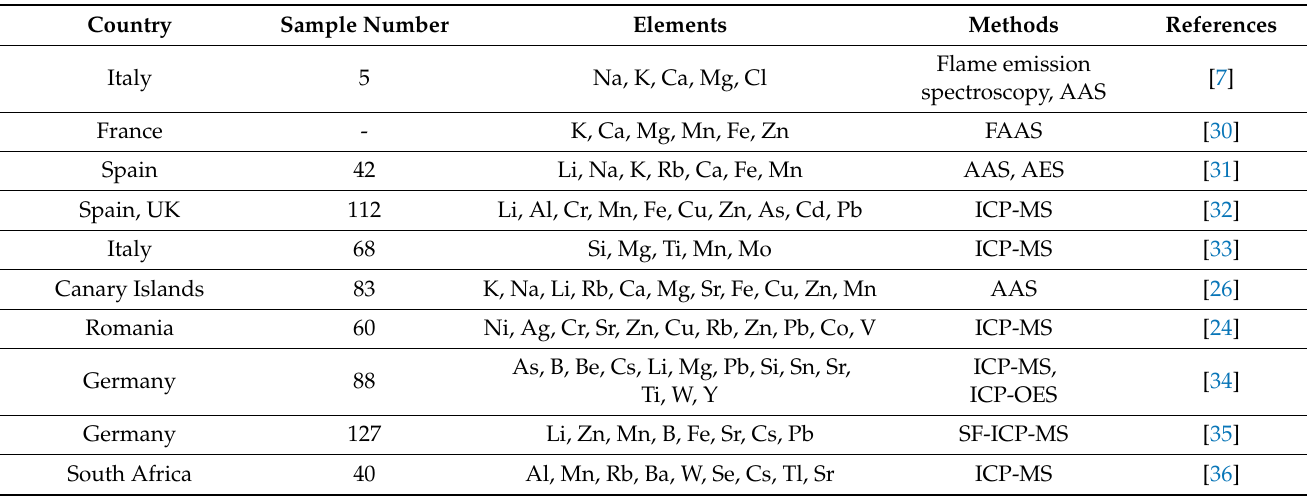
Table 1. Studies and analytical techniques to confirm the authenticity of wines according to the quantification of mineral